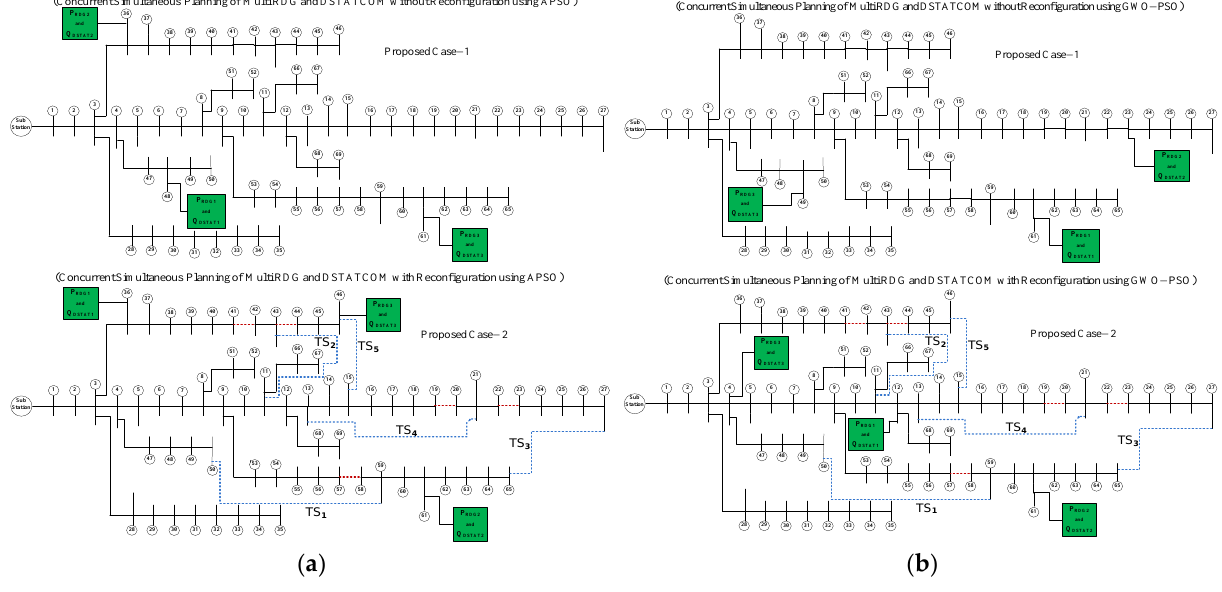
Figure 19. Proposed IEEE 69-bus RDN for both proposed cases; ( a ) APSO, ( b ) GWO-PSO.